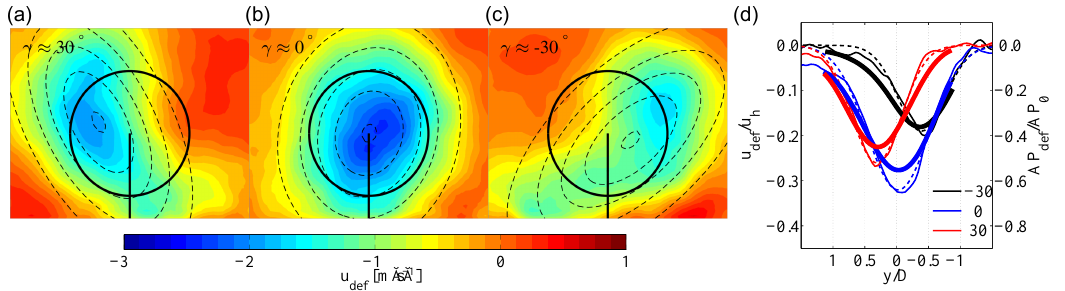
Figure 5. (a–c) Mean wake deficit 6D downstream of a wind turbine in the NBL. The turbine is yawed by (a) 30 ◦ , (b) 0 ◦ and (c) − 30 ◦ . Straight contours denote the position of the upstream turbine. Dashed contours are the isolines of constant f 2D . (d) Cross sections of normalized u def at hub height (thin) and results of f AP (bold) and f h (dashed).